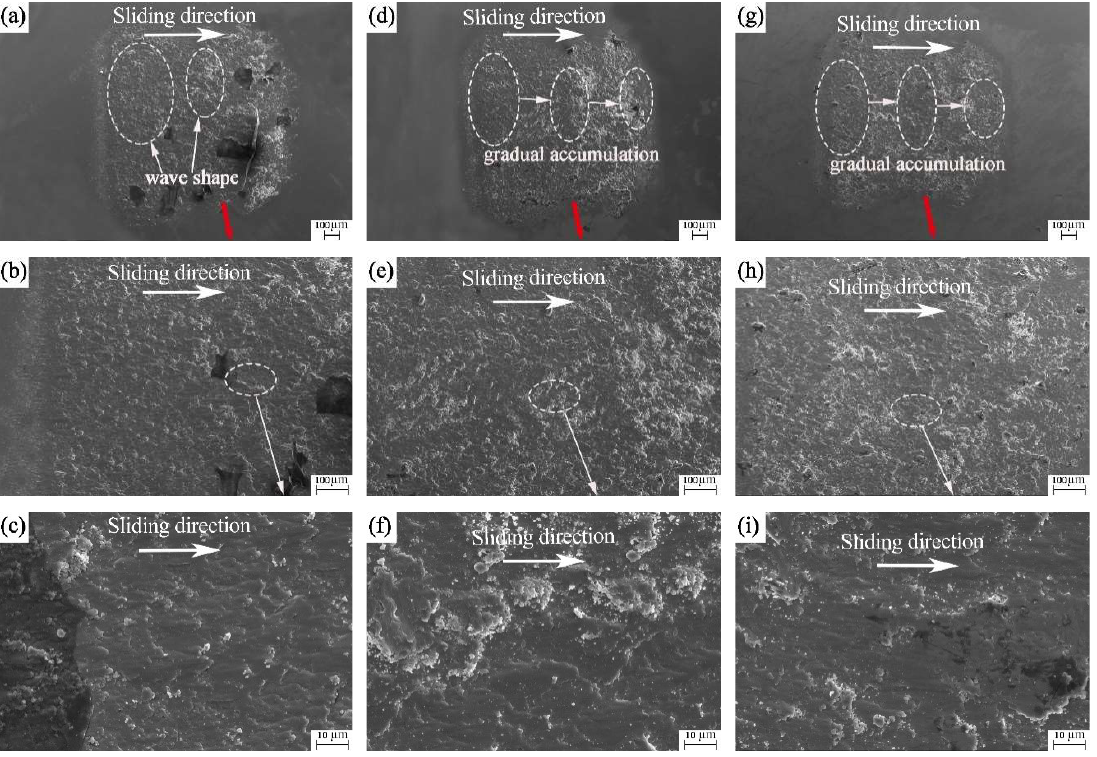
Figure 12. SEM images of the electric-spark-textured worn balls: ( a – c ) rotation radius 15 mm; ( d – f ) rotation radius 18 mm; and ( g – i ) rotation radius 22.5 mm.